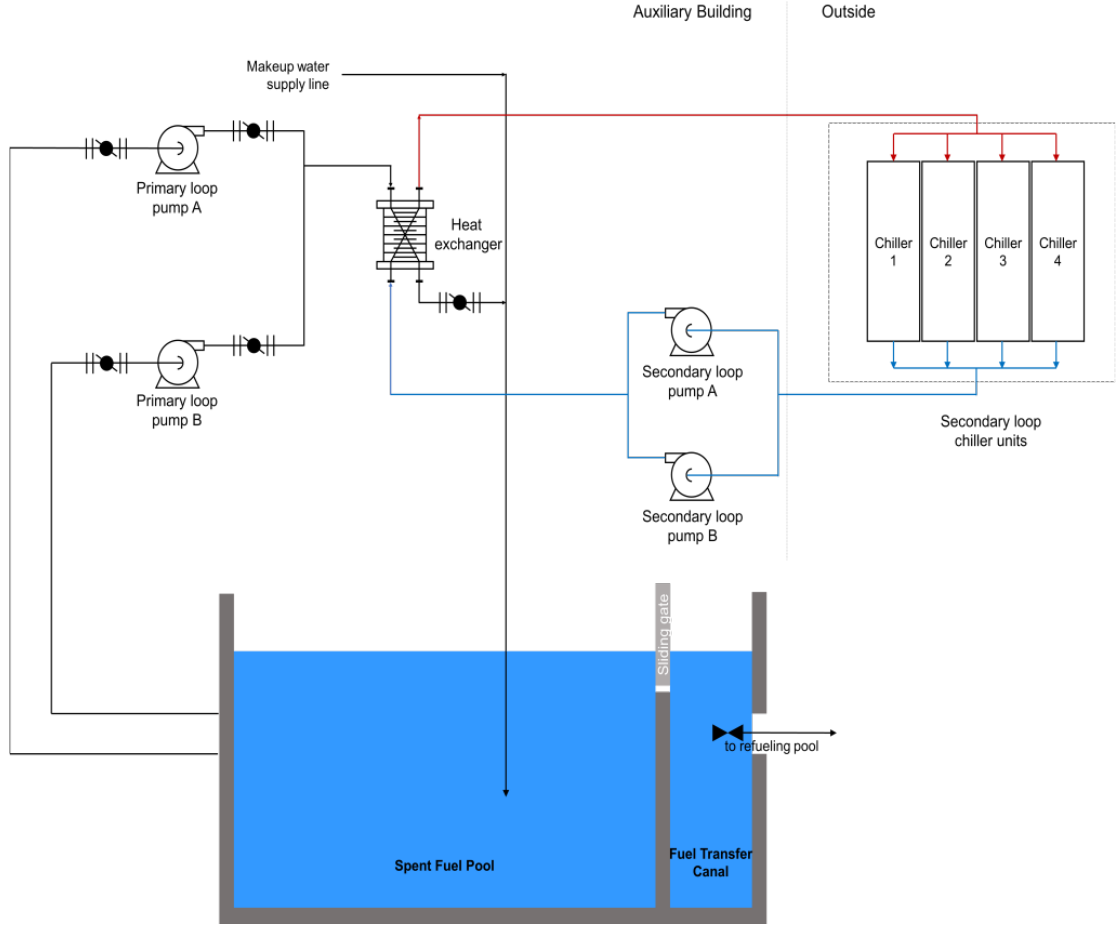
Figure 7. Configuration of an applicable cooling system.